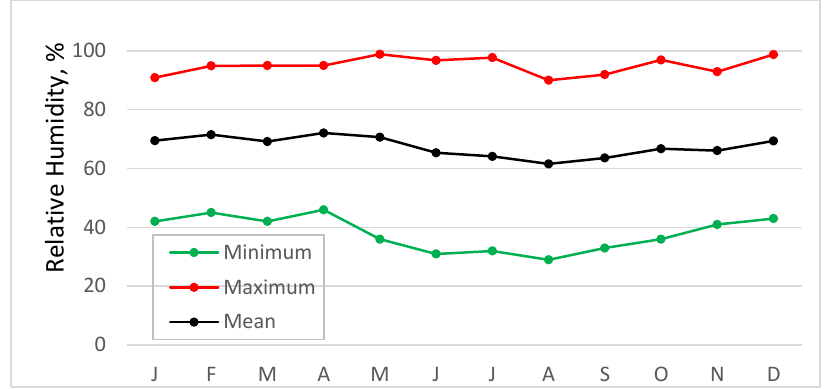
Figure 4. Monthly relative humidity profiles.